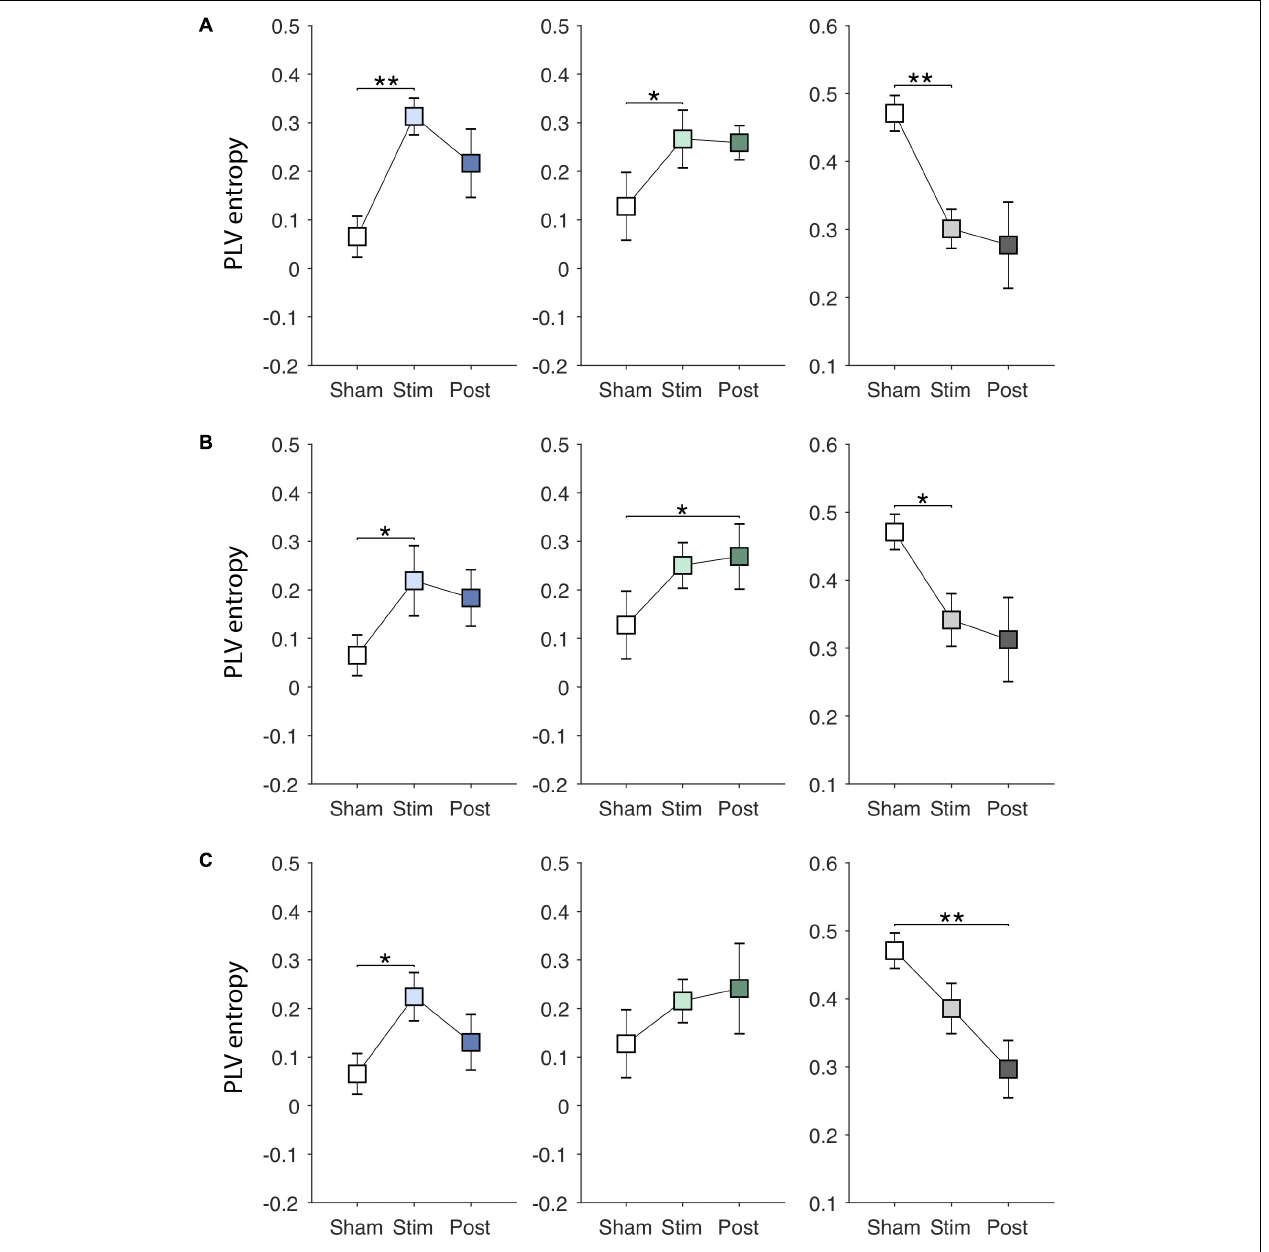
FIGURE 6 | Effects of EVS on the PLV entropy. The PLV entropy values in the sham condition are identical to those in Figure 3A . Descriptions for the arrangement of the plots and statistical significance are same as in the Figure 4 . (A) EVS1 effects. (B) EVS2 effects. (C) EVS3